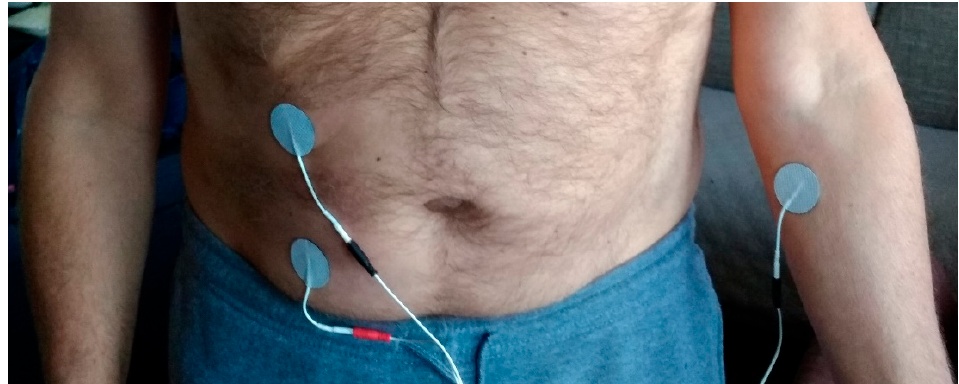
Figure 5. Electrodes placement in the measurement of EMG signal for the right abdominal muscle (lat. musculus rectus abdominis ).